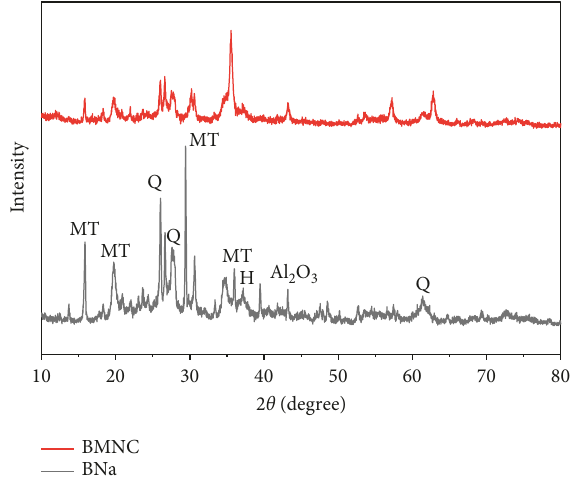
Figure 5: XRD diffraction of bentonite (BNa) and nanocomposite adsorbent